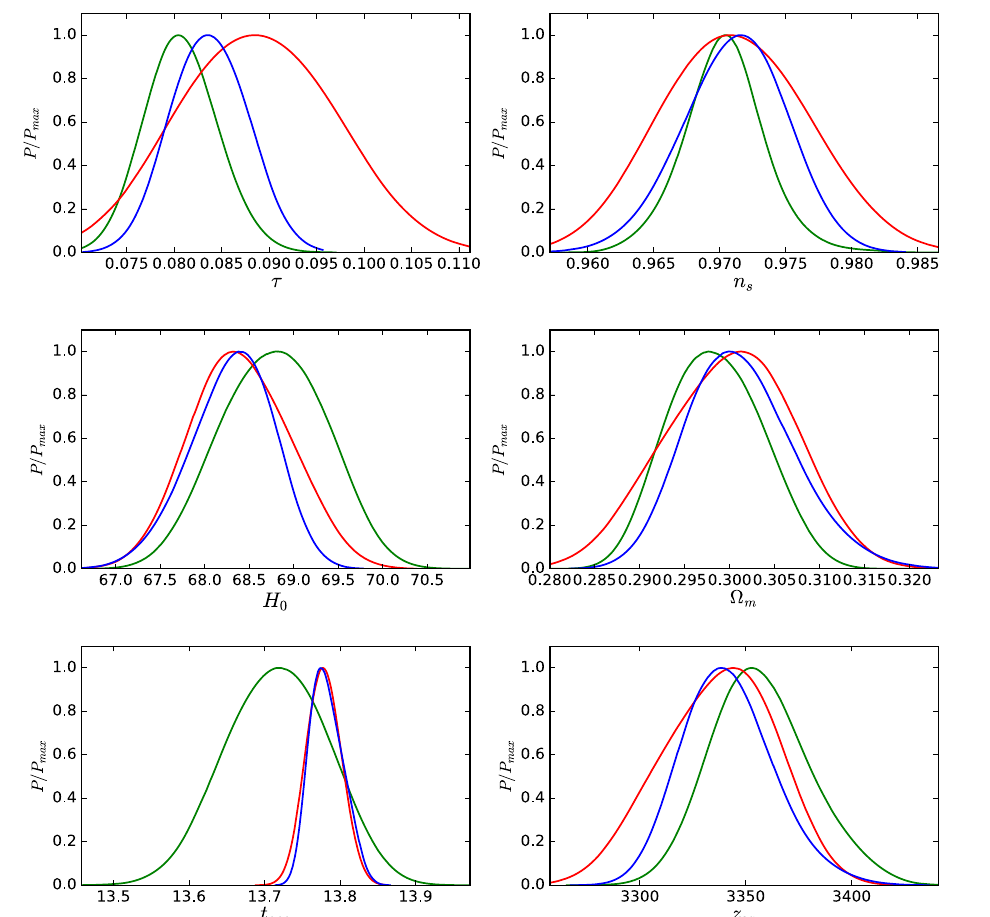
Fig. 9 The 1-dimensional posterior distributions of τ , n s , H 0 , (cid:11) m , t age and z eq in the V (cid:4) DE (blue), V ω DE (red) and VKDE (green) models using the data combination CSBCHLW, respectively Fig. 10 The 2-dimensional marginalized contour in the η – σ 8 plane and 1-dimensional posterior distribution of σ 8 for the V (cid:4) DE (blue), V ω DE (red) and VKDE (green) models using data combination